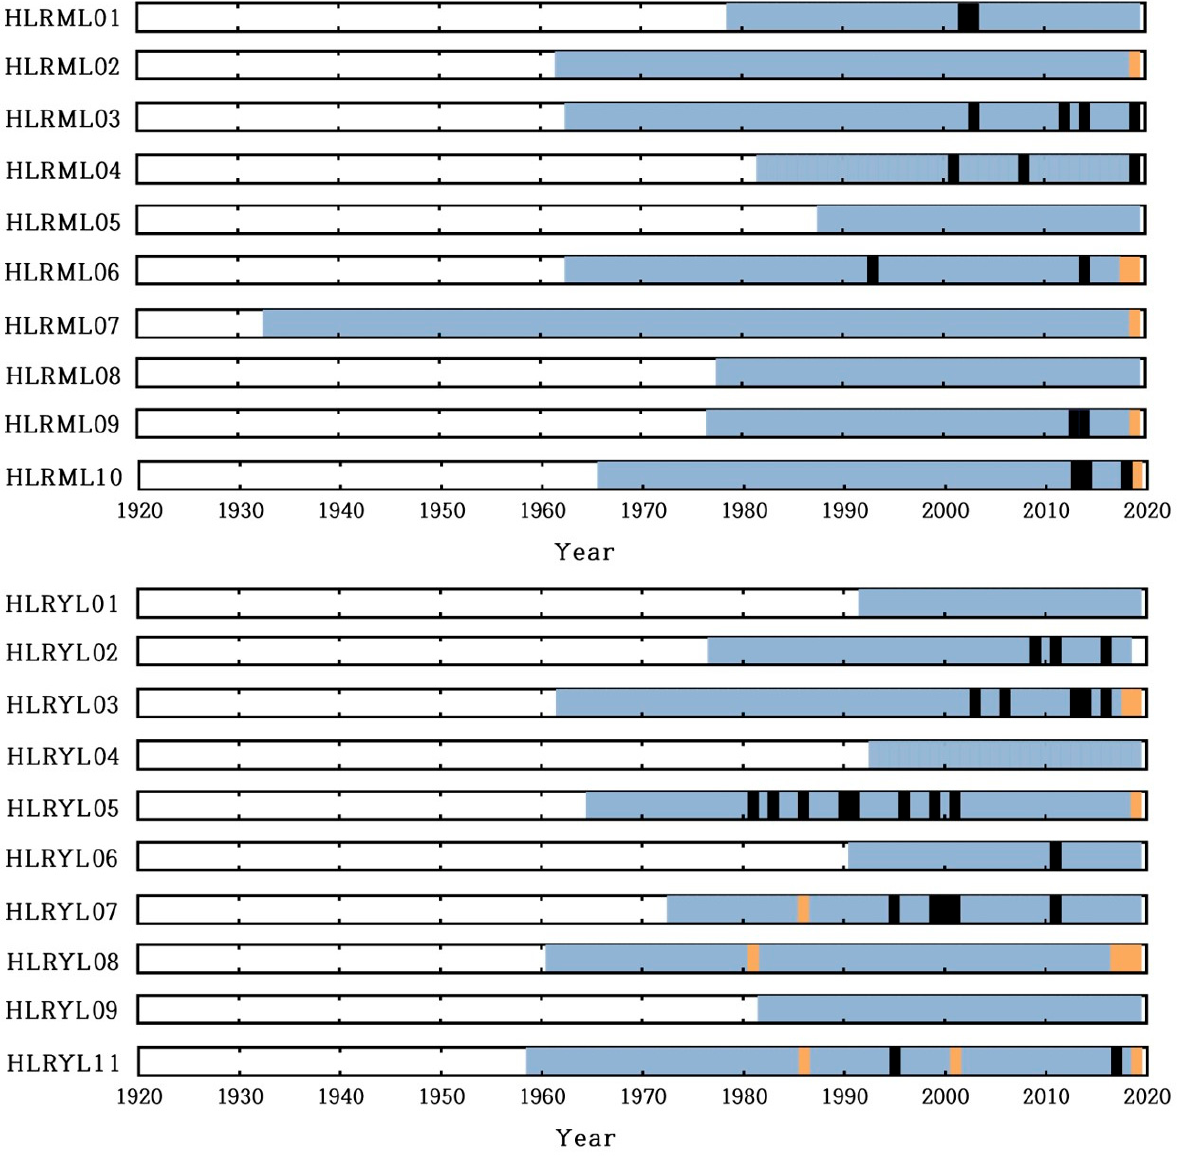
Figure 4. Missing (orange) and discontinuous (black) rings in individual living shrubs (HLRML: R. mucronulatum , HLRYL: R. yedoense ) and their frequency for each year (blue background: the length of time series). Table 3. Statistics information on the chronologies of R. yedoense and R. mucronulatum (Rwt: correla- tion coefficients within trees, Rbt: correlation coefficients between trees, EPS: expressed population signal, AC1: first-order